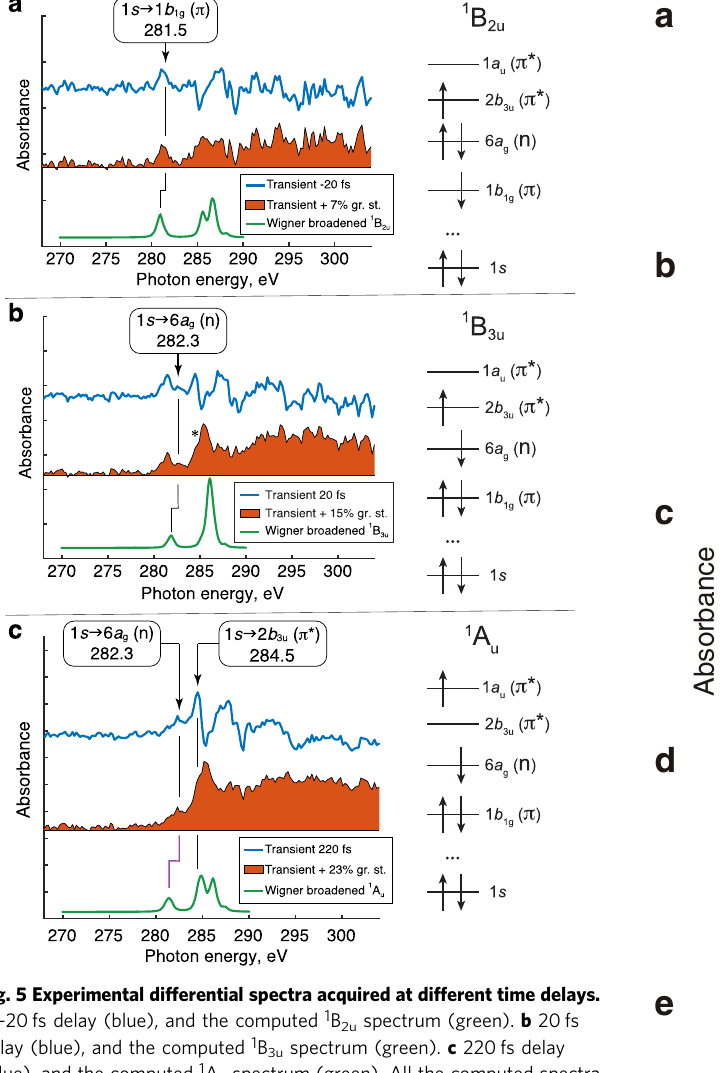
Fig. 5 Experimental differential spectra acquired at different time delays. a – 20 fs delay (blue), and the computed 1 B 2u spectrum (green). b 20 fs delay (blue), and the computed 1 B 3u spectrum (green). c 220 fs delay (blue), and the computed 1 A u spectrum (green). All the computed spectra are calculated for the ground-state Wigner distribution. The brown- fi lled spectra are the differential traces corrected for ground-state bleach. The added ground state percent is determined from the pump fl uence and absorption cross-section of pyrazine at 267 nm; for − 20 and 20 fs delays the temporal overlap of the pump and probe is also taken into account, see Supplementary Note 3. Prevailing electron con fi gurations of the corresponding valence excited states are sketched on the right.